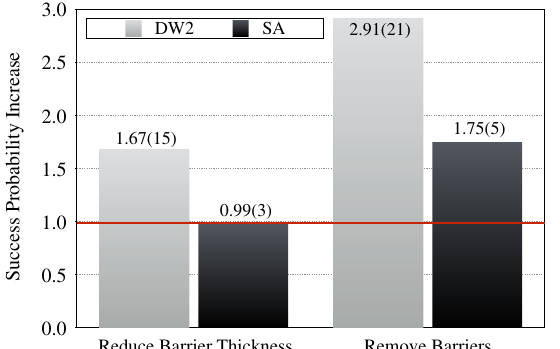
FIG. 5. Average success probability increase when reducing the barrier thickness (ratio between the average success probabilities for S 28 thick and S 28 thin) and removing the barriers (ratio between the average success probabilities for S 28 thick and S 28 none). While in the latter case both classical algorithms and the quantum annealer show a performance boost on average, in the former only the quantum annealer shows improvement.